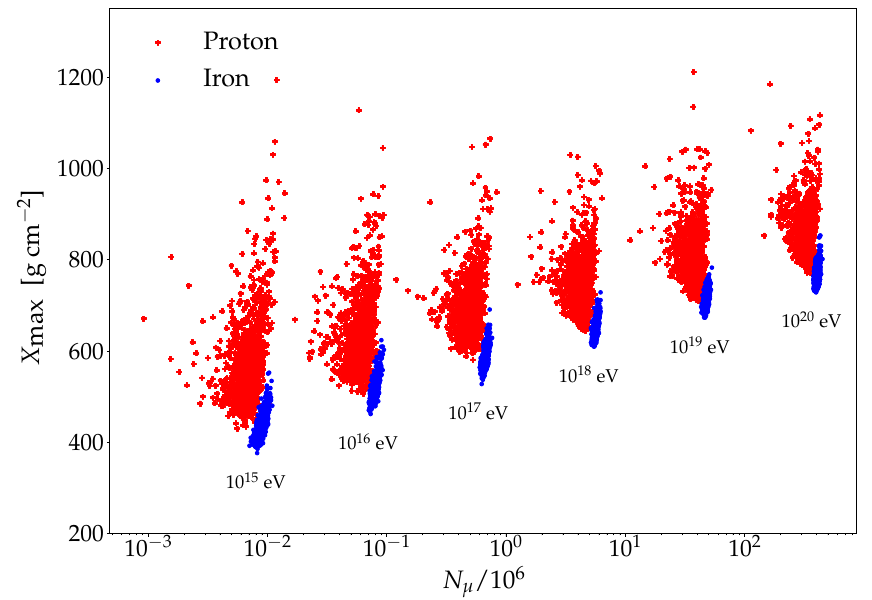
Figure 4. Depth of the shower maximum versus the number of muons at ground level for proton- and iron-initiated air showers and for different values of primary energy. The zenith angle is θ = 40 ◦ . The observation level is located at sea level, the threshold energy of the muons is 1 GeV, and the simulations are performed with